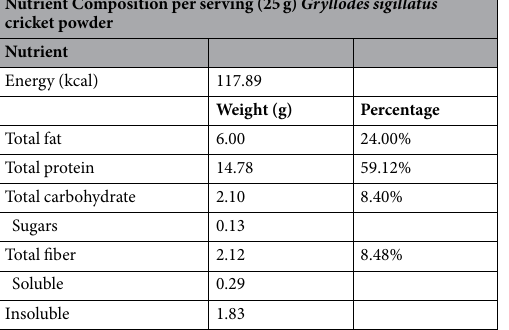
Table 2. Estimated Nutrient Composition of Cricket Powder per serving (25 g). Both soluble and insoluble fiber were determined using Official Method 991.43 of the AOAC 86 . Estimate does not include ash, vitamins,